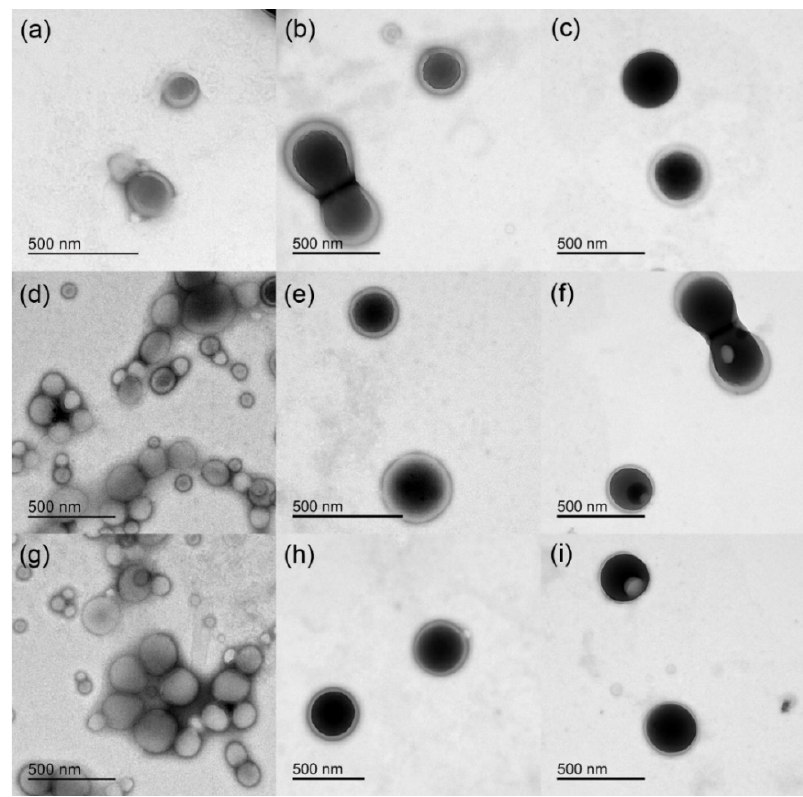
Figure 4. TEM micrographs of the different NPs: ( a ) PVA, ( b ) PVA with DOXO, ( c ) PVA with SN- 38, ( d ) DEX, ( e ) DEX with DOXO, ( f ) DEX with SN-38, ( g ) PVA/DEX, ( h ) PVA/DEX with DOXO, ( i ) PVA/DEX with SN-38.